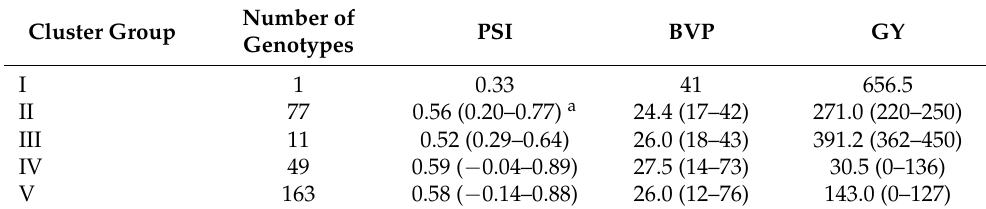
Table 1. The number of genotypes, PSI, BVP, and grain yield (GY) of each group based on cluster